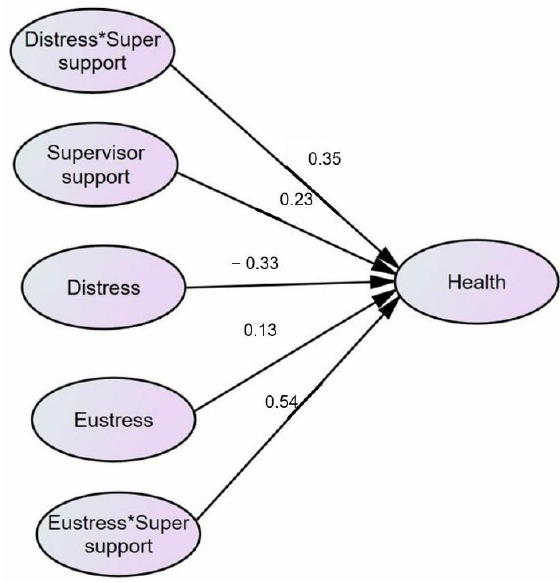
Figure 4. Moderation analysis supervisor support.